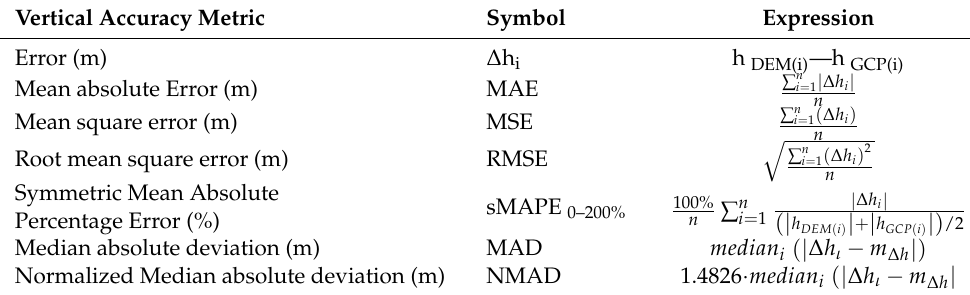
Table 2. The statistical metrics for the vertical accuracy assessment of DEM. Vertical Accuracy